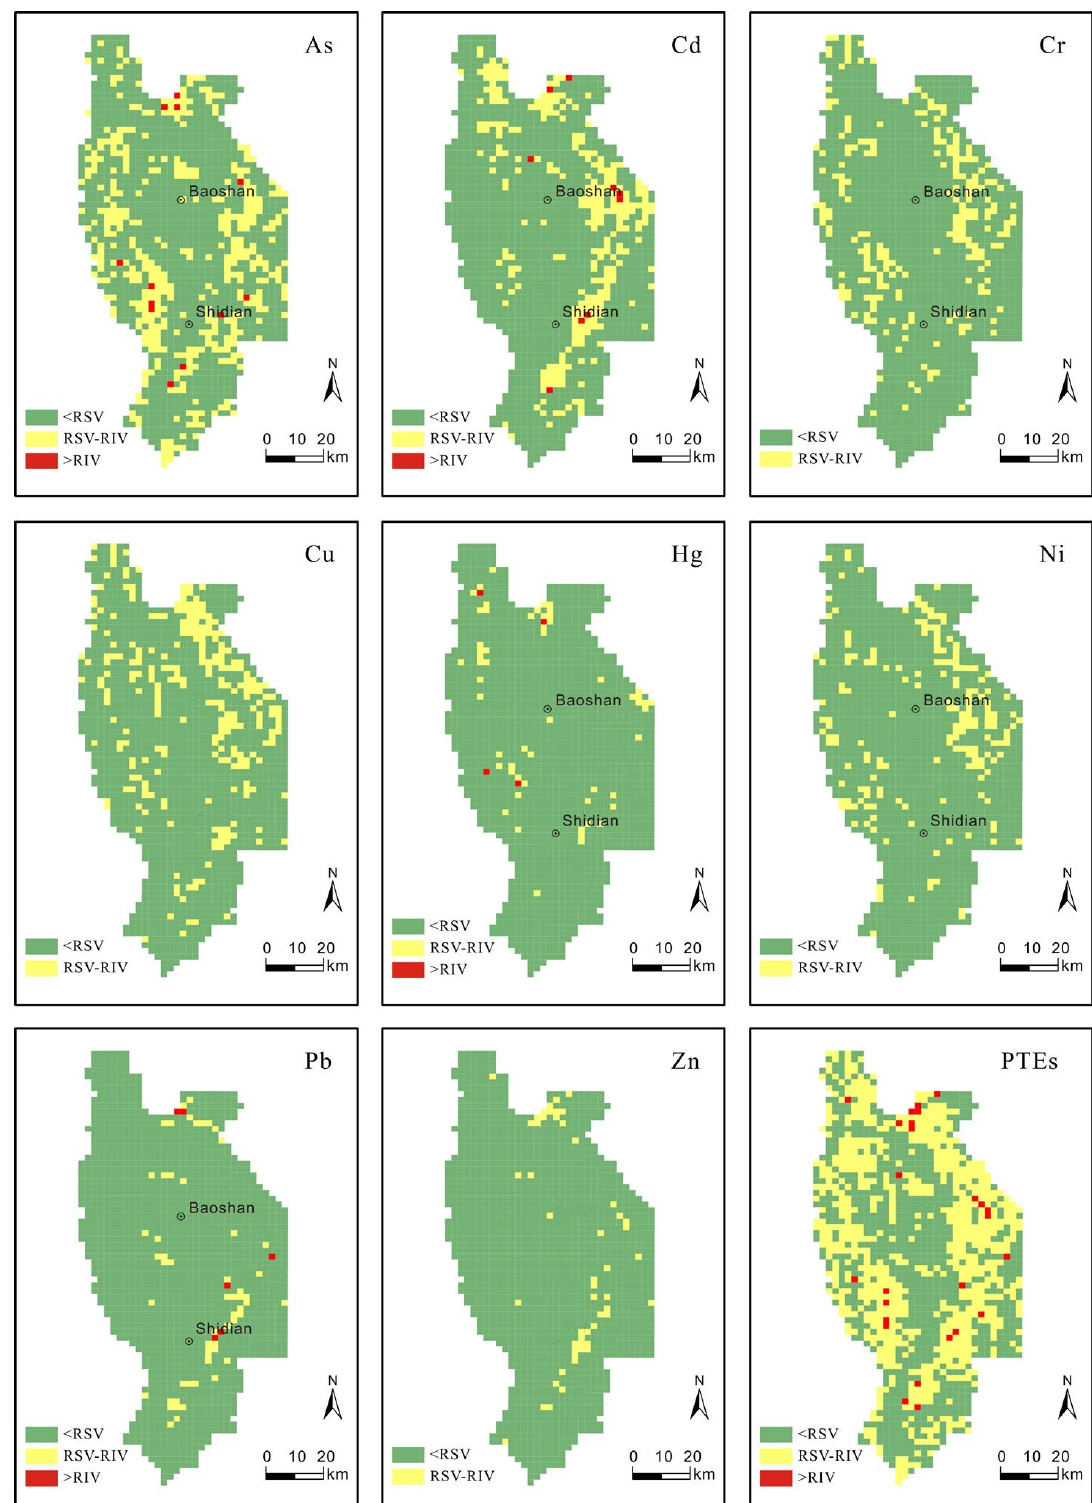
Figure 2. The distribution of soil environmental quality based on the risk control standard for soil contamination of agricultural land of